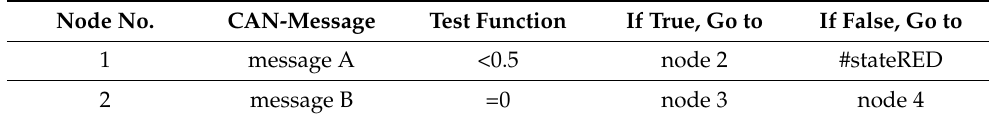
Table 4. Example of tree-algorithm stored in backend-database.